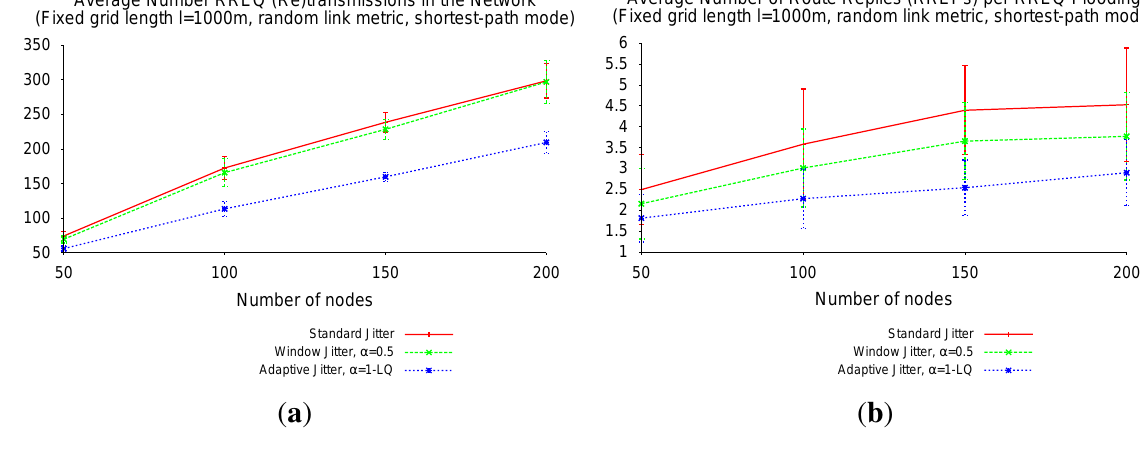
Figure 13. Route overhead per route discovery, shortest-path RREQ flooding. ( a ) The number of RREQ (re)transmissions; ( b ) The number of RREP (re)transmissions.